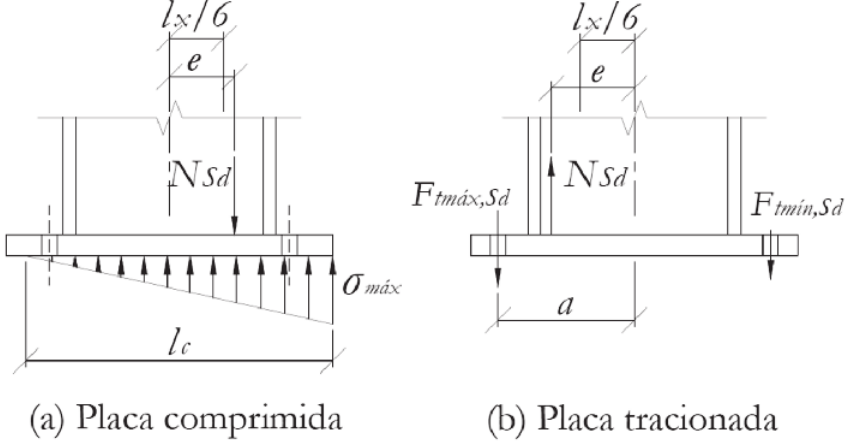
Bases em intervalo de excentricidade não coberto pela hipótese linear